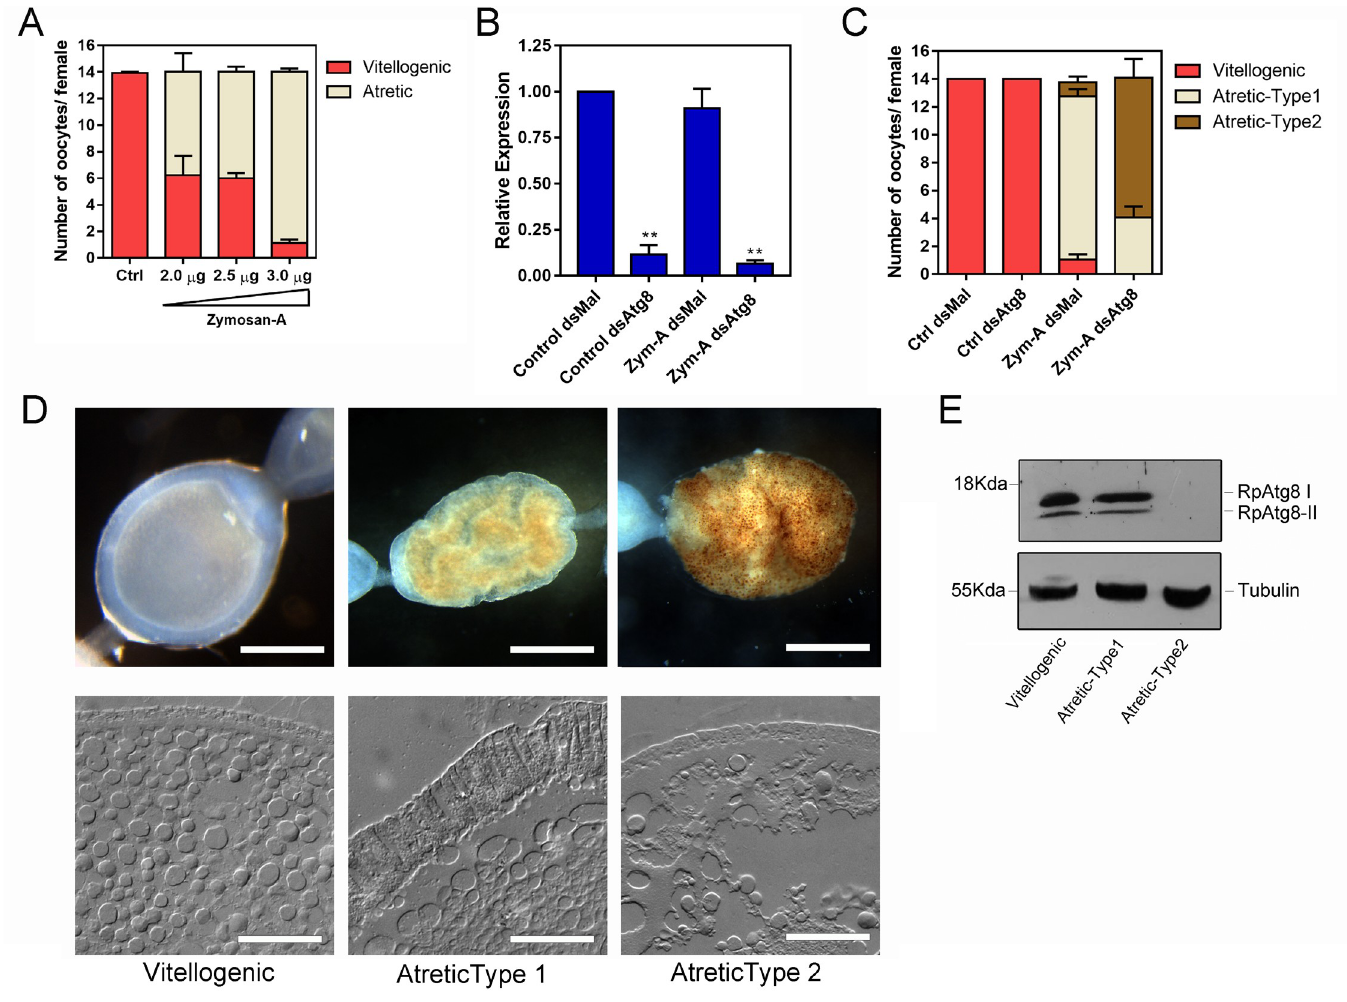
Fig 3. Silencing of RpATG8 results in the same number of atretic oocytes, but with a different morphology. A. Increasing concentrations of Zymosan-A were directly injected in the hemocoel of 10 vitellogenic females per treatment 3 days after the blood meal and the number of atretic oocytes was accessed 7 days after the blood meal. Graph shows mean ± SEM (n = 10). B. Levels of RpATG8 mRNA silencing in control and Zymosan-A-challenged females, 7 days after the blood meal. dsMal: control dsRNA, dsATG8: dsRNA designed to specifically target the RpATG8 sequence. Graph shows mean ± SEM (n = 6). �� p < 0.01, ��� p < 0.001, One Way ANOVA. C. The challenge with Zymosan-A was performed in control and silenced females and the number and types of atretic oocytes were accessed in 10 insects per treatment. Graph shows mean ± SEM (n = 10). D. Both types of atretic oocytes were observed under the stereomicroscope (Upper panel, Bars: 0.5 mm) and cryosections were observed in the light microscope operating in differential interferential contrast mode (Lower panel). Bars: 500 μ m. E. Immunoblotting to test the silencing of RpATG8 in control and atretic oocytes. Tubulin was used as loading control (n =